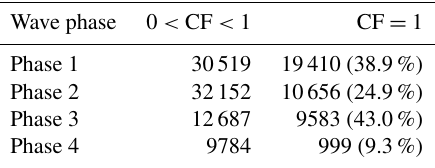
Figure 5. Distribution of cloud fraction in each gravity wave phase. Blue and red colored lines indicate the cold and warm phases, re- spectively, while the solid and dashed lines represent d T (cid:48) / d z > 0 and d T (cid:48) / d z < 0. The number of cases with cloud fractions of zero or unity are excluded. Table 1. Number of cases with cloud fraction (CF) between 0 and 1 (sum of cases in Fig. 5) and CF = 1. The percentage represents the number of CF = 1 cases over the sum of the respective